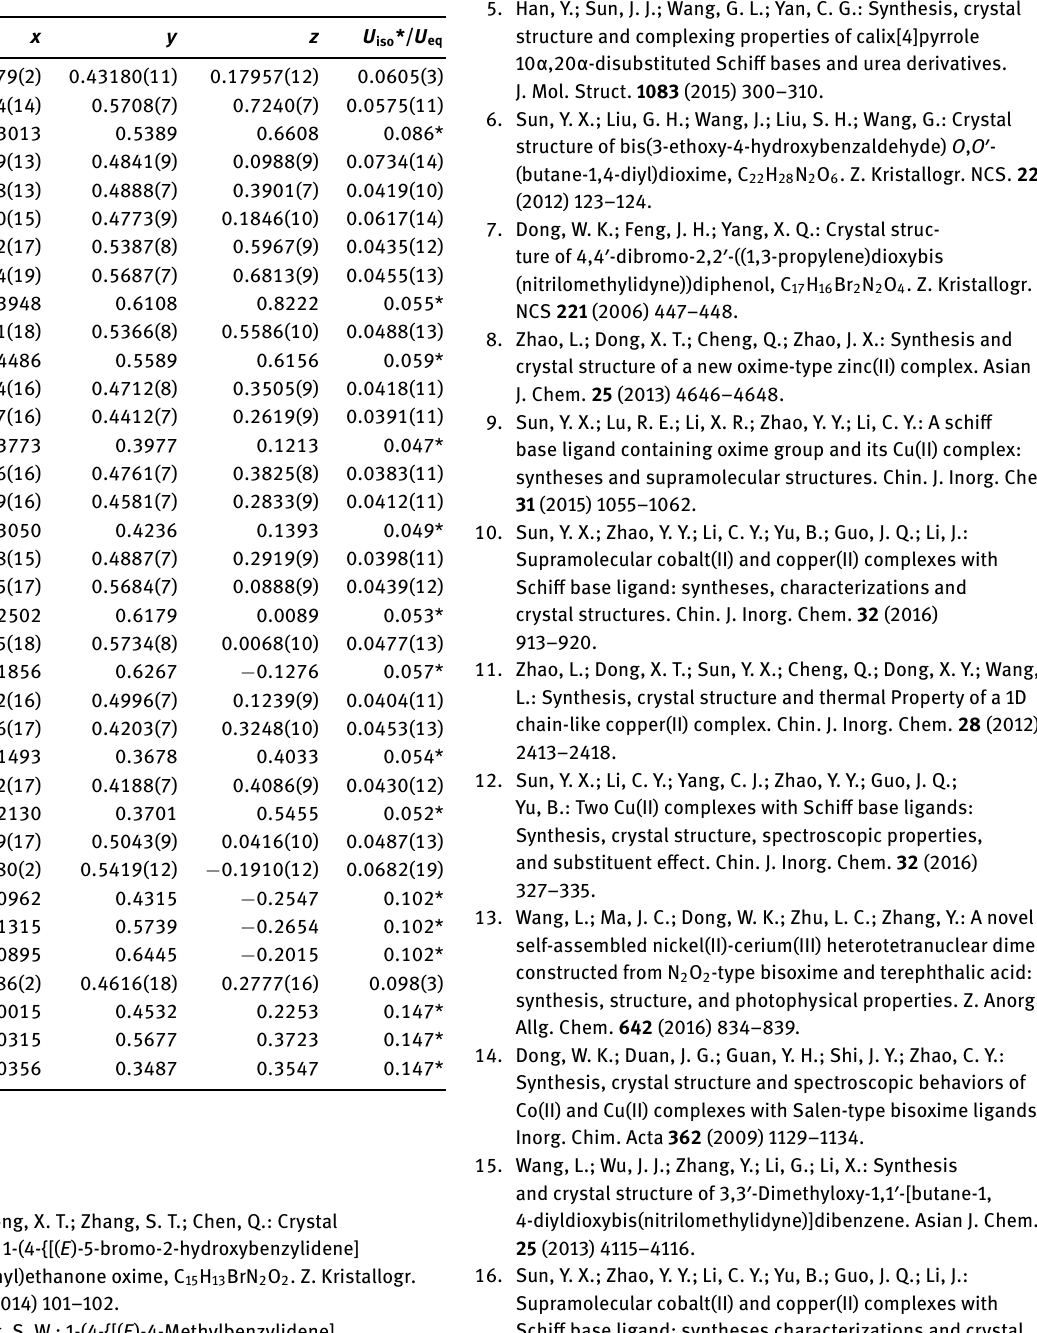
Table 2: Fractional atomic coordinates and isotropic or equivalent isotropic displacement parameters (Å 2